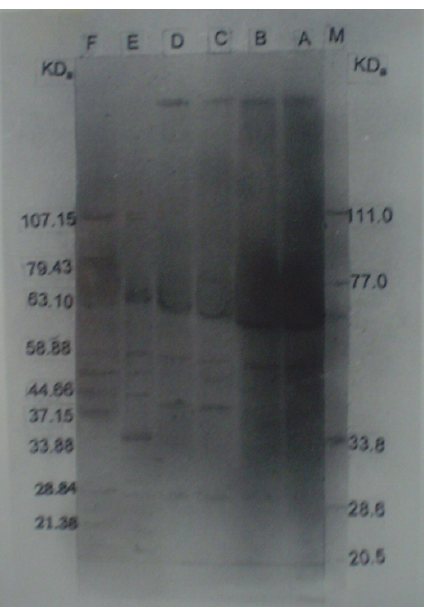
Figure 5: Immunoblot analysis of whole cell and sonicated super- natant antigens against M. bovis NC 317 hyperimmune sera. Lane A: WCA of M. agalactiae RPNS 216. Lane B: WCA of M. agalactiae RPNS 210. Lane C: SSA of M. agalactiae RPNS 216. Lane D: SSA of M. agalactiae RPNS 210. Lane E: SSA of M. bovis NC 317. Lane F: WCA of M. bovis NC 317. Lane M: molecular weight marker.